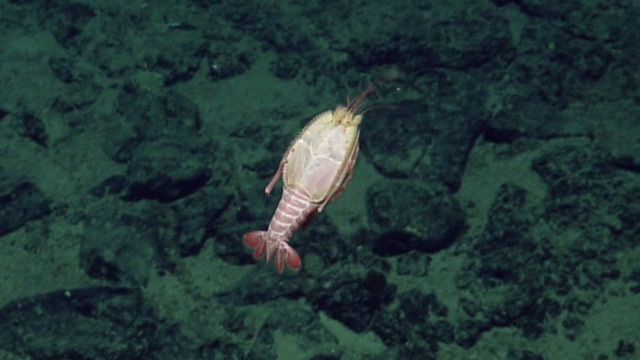

Pentacheles
laevis